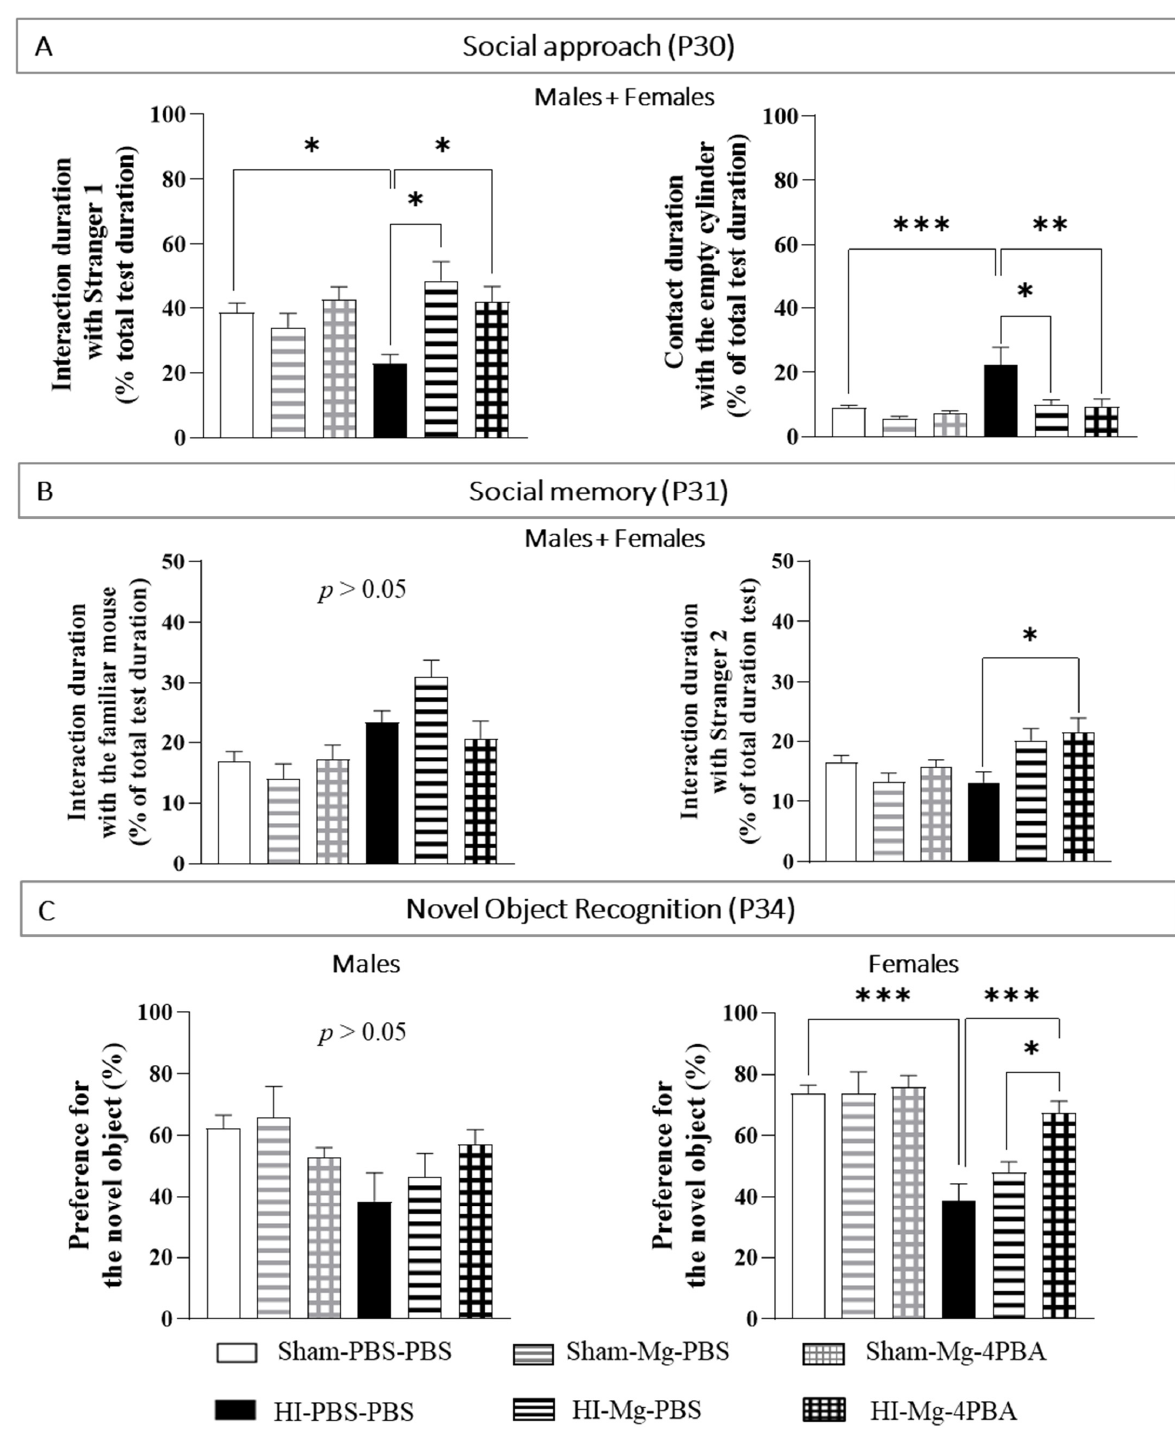
Figure 3. Effects of neonatal HI, MgSO 4 or of the MgSO 4 /4-PBA association on cognitive capacities in adolescent male and female mice. ( A )—Interaction duration with Stranger 1 and contact duration with the empty cylinder (% of total test duration) were measured with the social approach test at P30. n = 6–16 mice/group. Sexes are pooled. ( B )—Interaction duration with the familiar mouse and interaction duration with Stranger 2 (% of total test duration) were measured with the social memory test, performed at P31. n = 6–16 mice/group. Sexes are grouped. ( C )—Percentage of preference for the novel object at P34. n = 5–14 males and 5-20 females/group. Data are expressed as M ± S.E.M. Two-way ANOVA was performed followed by Tukey’s post-test (* p < 0.05, ** p < 0.01, *** p <